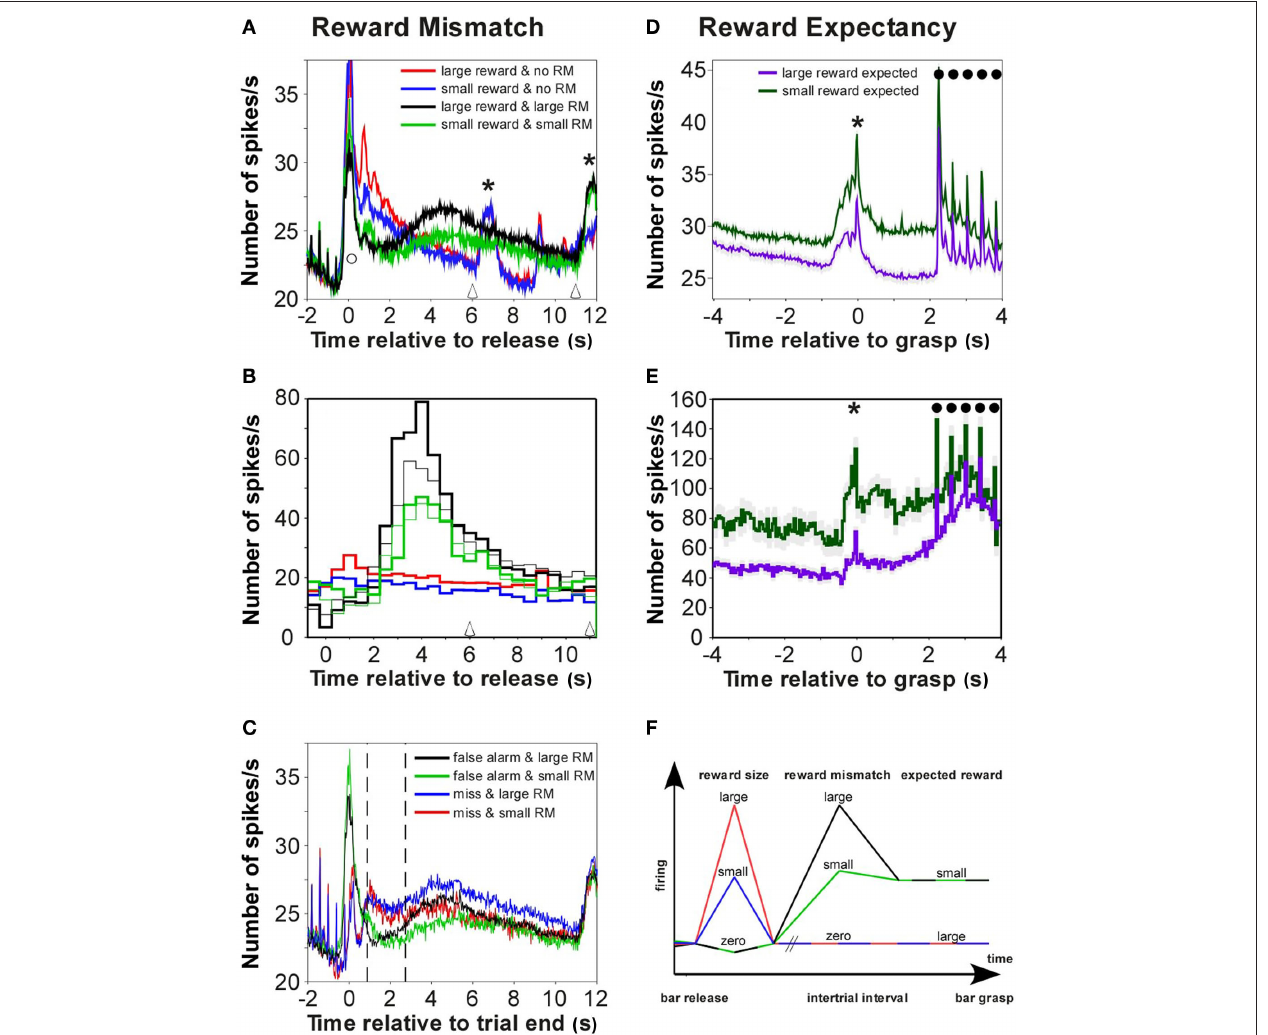
with misses, turning off the cue-light and the tones indicated trial end and that no reward will become available (blue and red curves for large and small RM, respectively). In false alarm trials (like in correct trials) the cue-light and the tones were turned off immediately after bar release (black and green curves for large and small mismatches, respectively); thus there was no cue regarding whether a reward will become available. (D) Grand average of the reward-expectancy firing of 626 multiunits when a small reward (green) was expected, or when a large reward (blue) was expected. Filled circles indicate the responses to the tones.